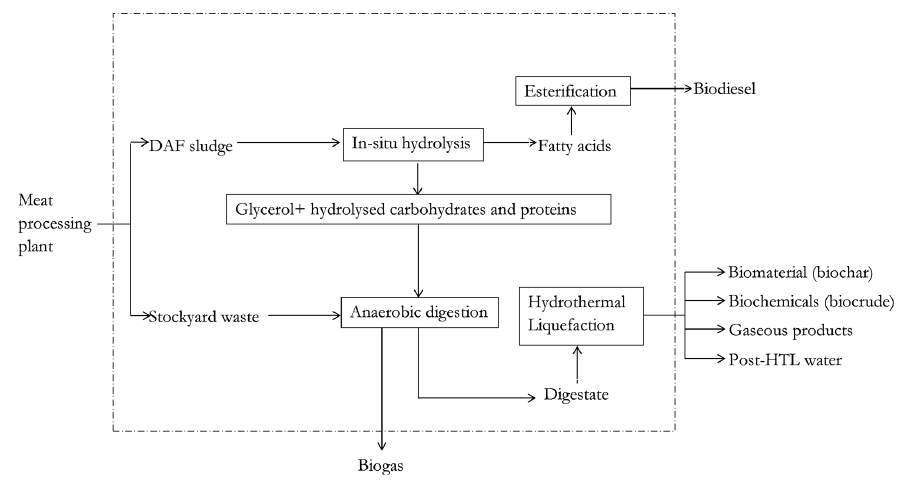
Figure 1. Biorefinery system using meat processing waste as the feedstock. DAF denotes dissolved air flotation sludge, HTL denotes hydrothermal liquefaction.